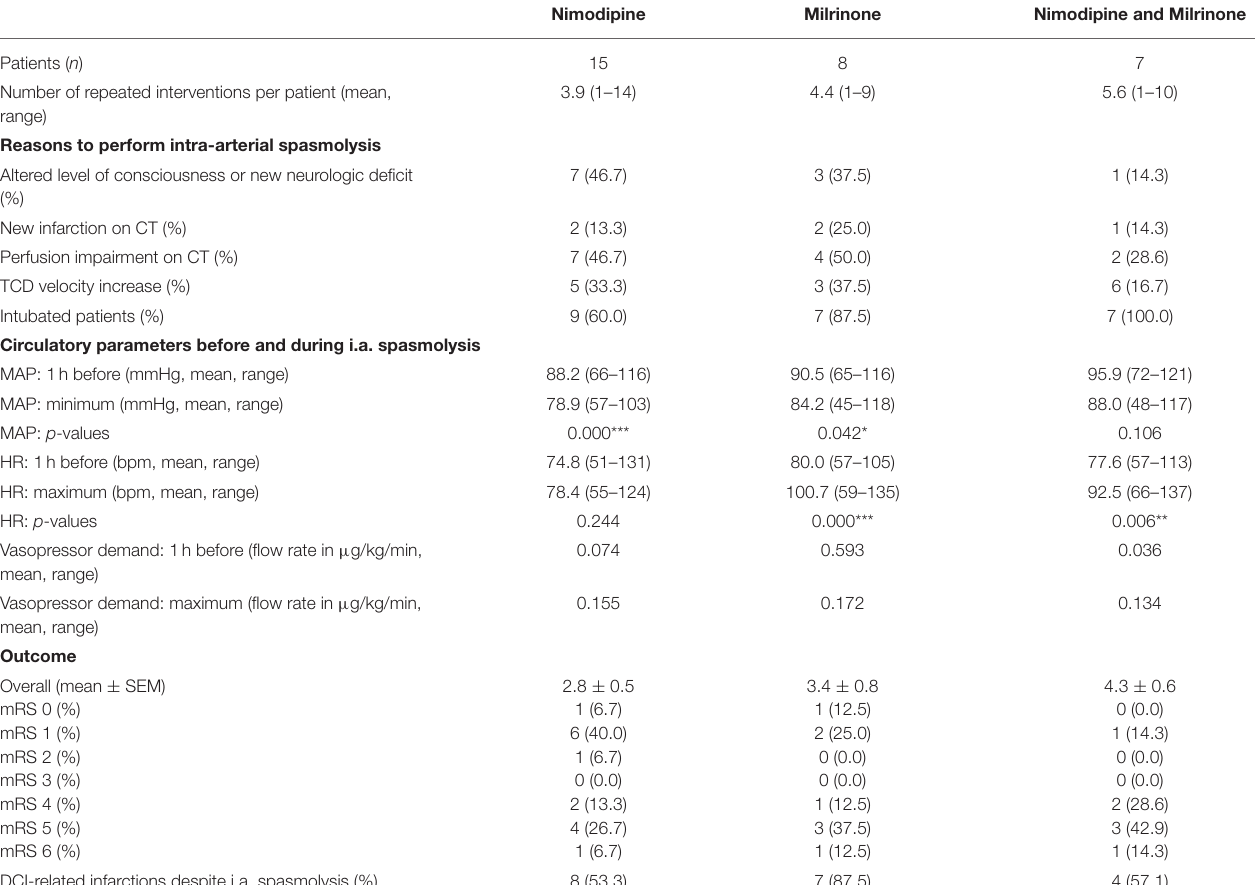
TABLE 2 | Intra-arterial spasmolysis and endpoint